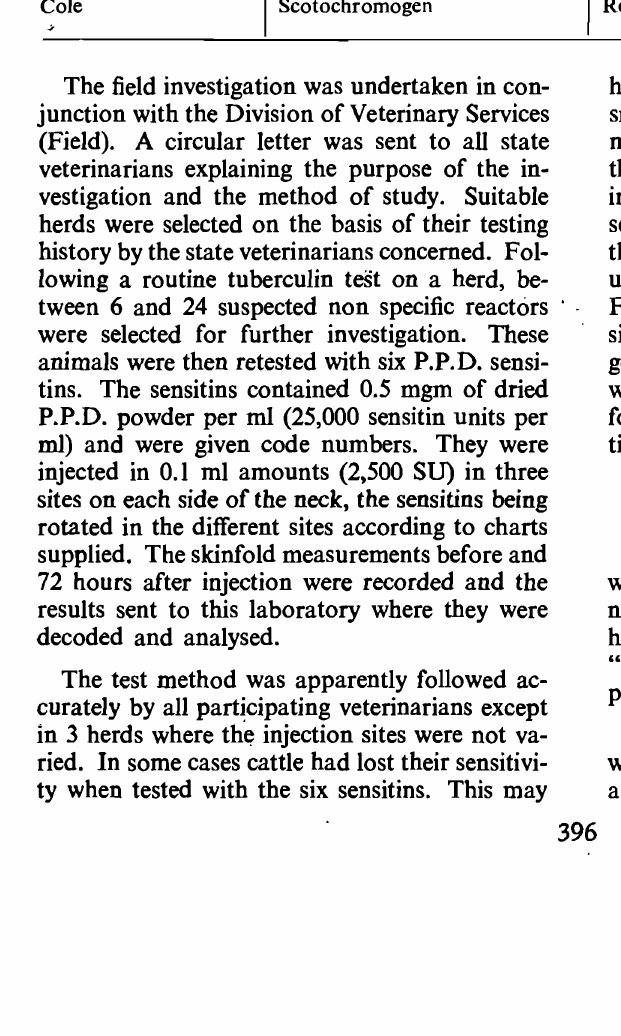
TABLE l.-STRAINS OF MYCOBACTERIA USED FOR P.P.D.